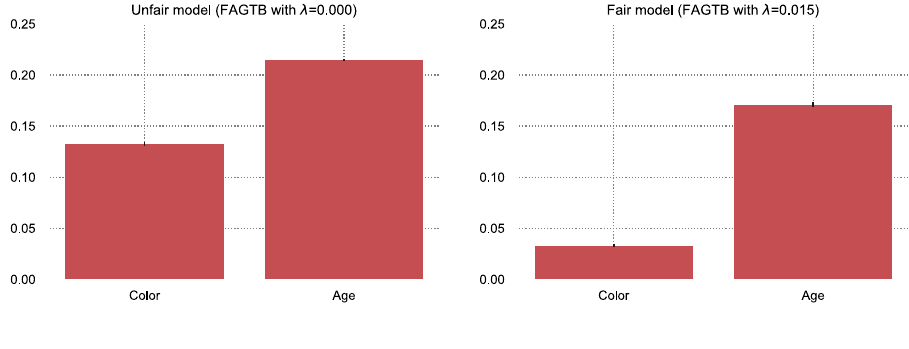
Fig. 3 Synthetic scenario: feature importance for a biased model ( 𝜆 = 0 ) and a fair model 0.015 ( 𝜆 = ) optimized for demographic